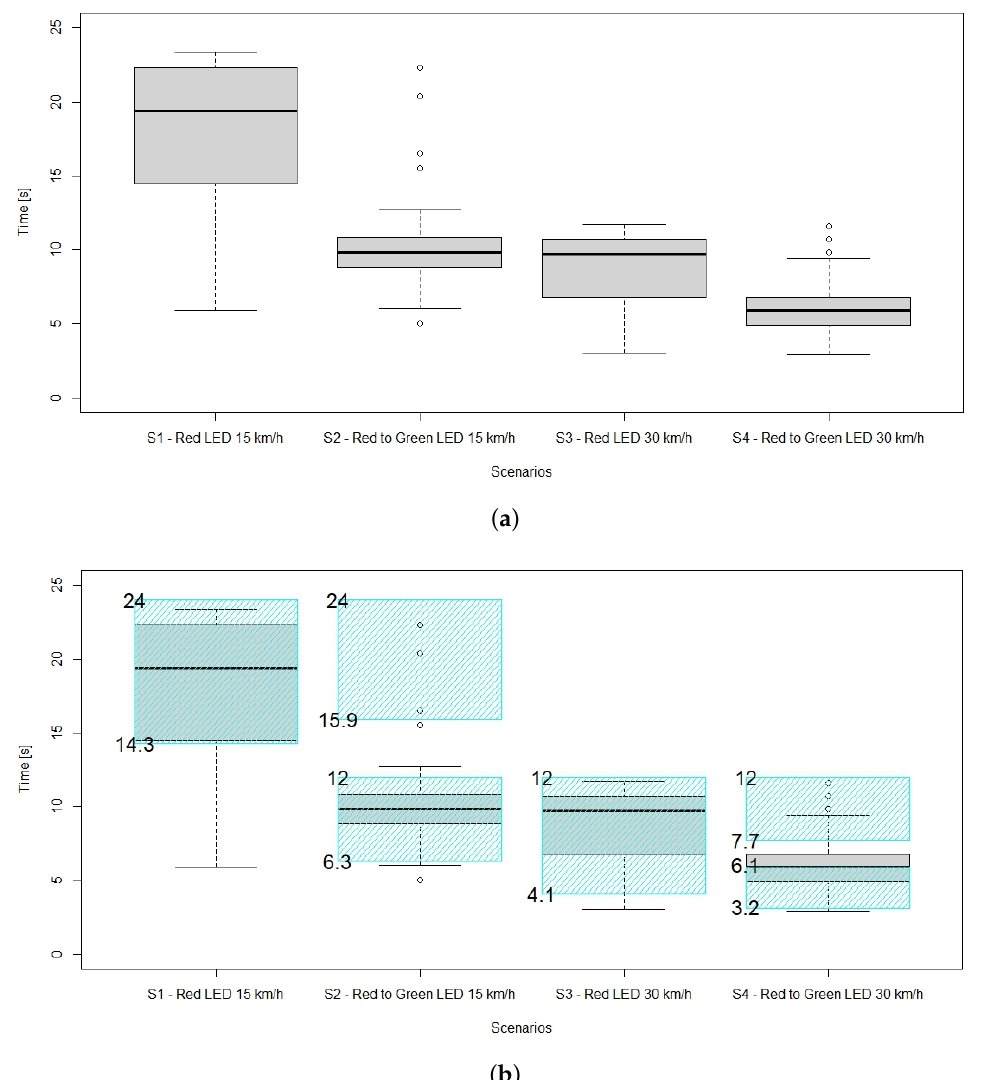
Figure 3. Boxplots of time required to make the decision to cross. ( a ) Distribution per scenario. ( b ) Safe to cross regions (shaded areas complying with scenarios in Figure